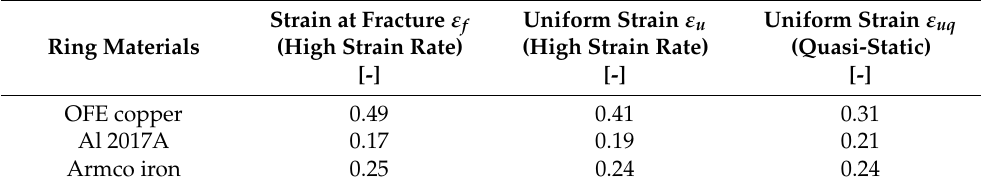
Table 1. Ductility parameters for tested SCL materials determined under quasistatic and high strain rate testing